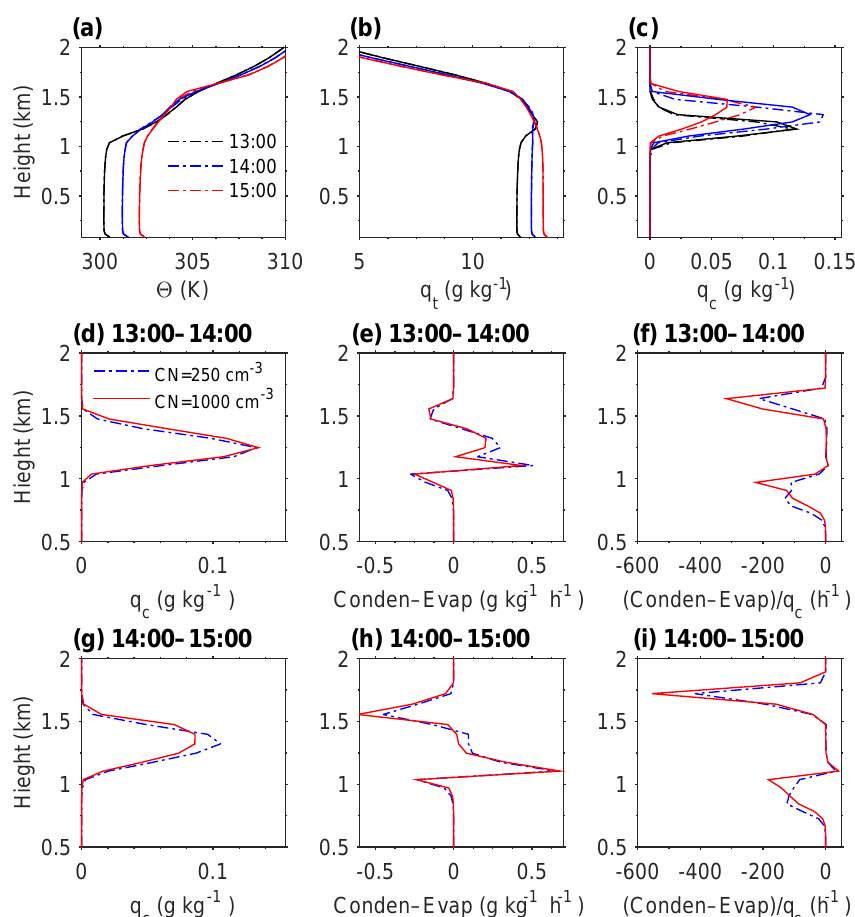
Figure 2. (a–c) Domain-averaged potential temperatures ( θ) , total water specific humidity ( q t ) , and cloud water content ( q c ) at three different times (13:00, 14:00, and 15:00) from two GCE cases with surface aerosol numbers equal to 250cm − 3 (dash–dotted curves) and 1000cm − 3 (solid curves). (d–f) Averaged profiles of q c , net results of condensation and evaporation (Conden–Evap), and (Conden–Evap) /q c for the 1h interval from 13:00 to 14:00 from the two CRM cases with surface aerosol numbers equal to 250cm − 3 (blue dash–dotted curves) and 1000cm − 3 (solid red curves). (g–i) Same as (d–f) except for the 1h interval from 14:00 to